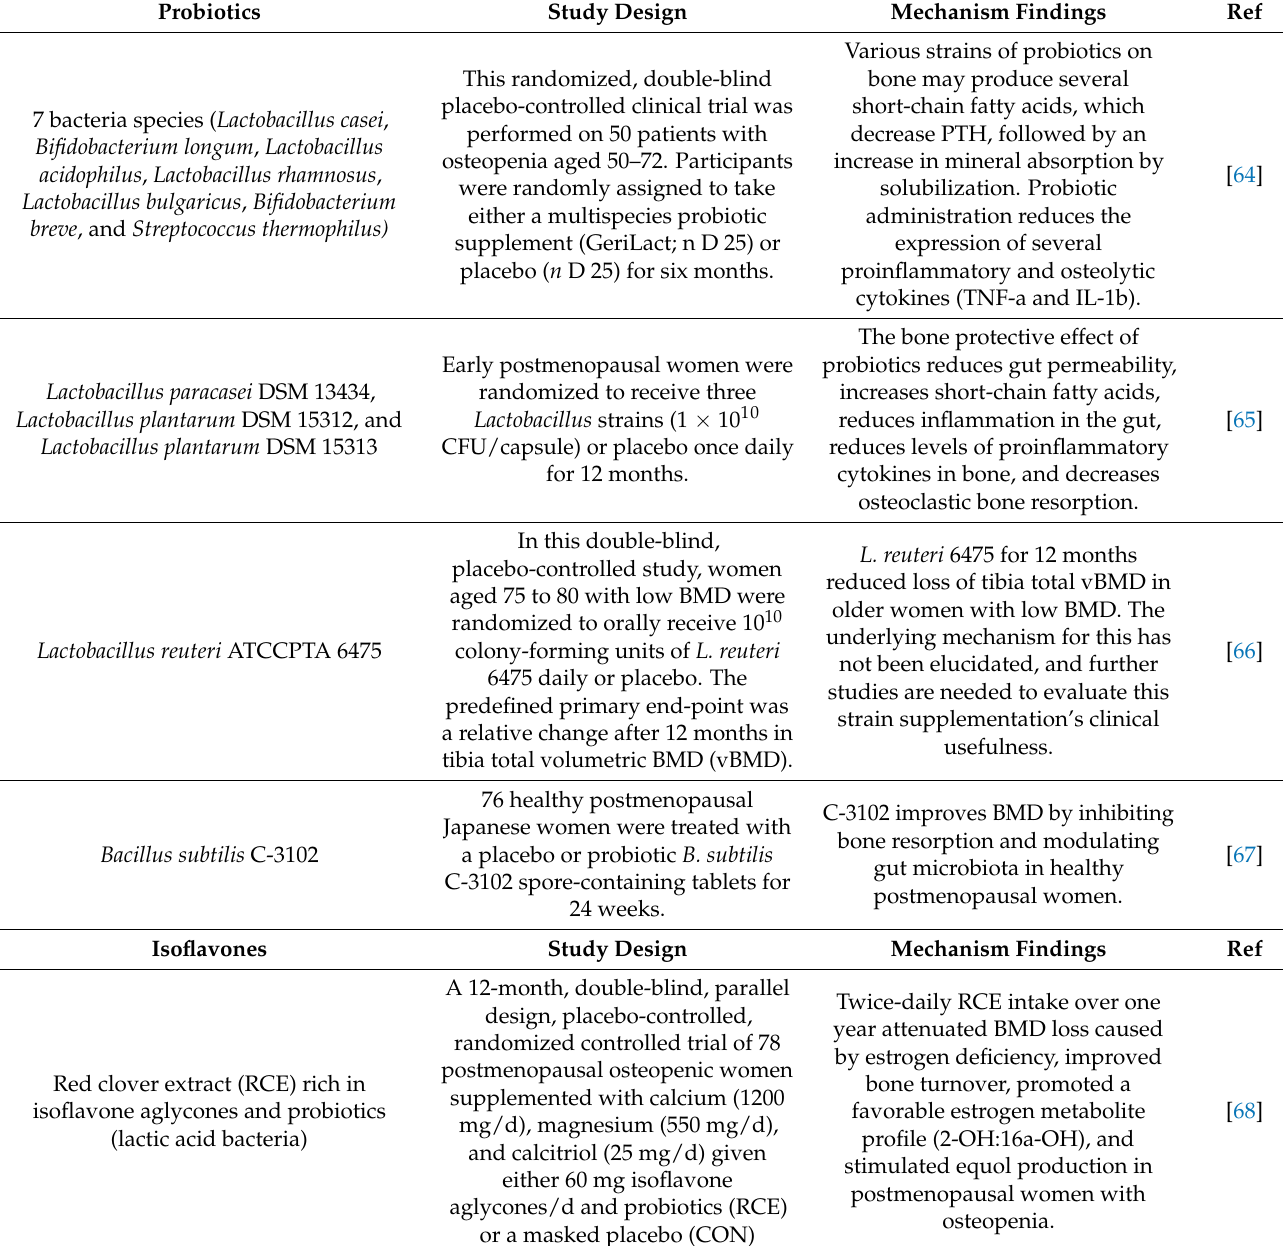
Table 5. Summary of human